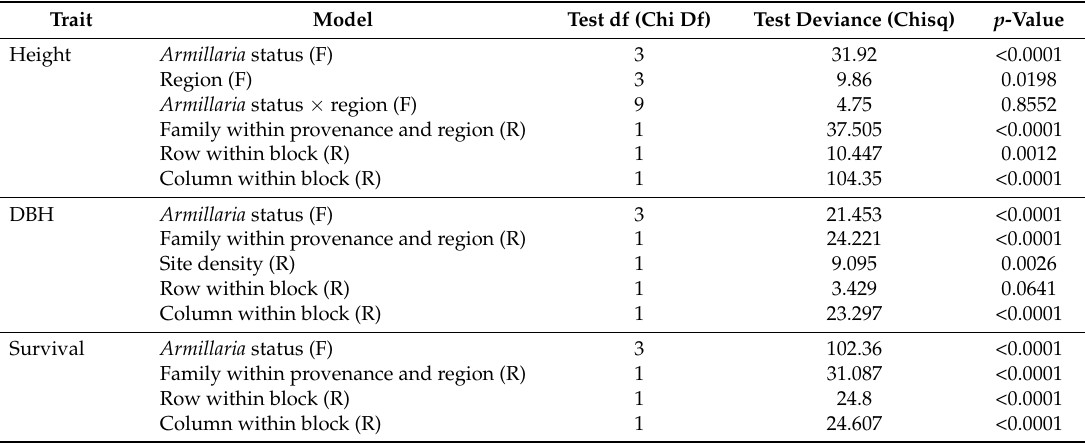
Table 4. A summary of the model comparison tests for the effects of Armillaria status and region of seed origin on western white pine ( Pinus monticola ) height, diameter (DBH), and survival at the Ida Creek site at the Priest River Experimental Forest in northern Idaho, USA.